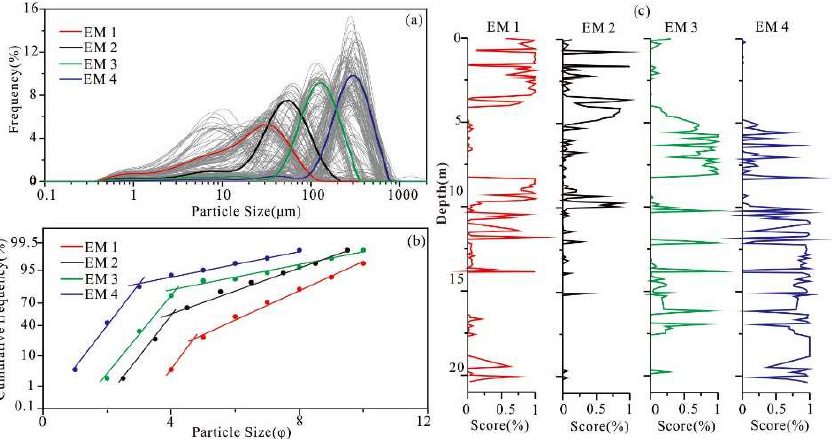
Figure 4. The hierarchical clustering endmember modeling analysis results. ( a ) Grain-size distributions (GSDs) of samples from sediment core HDZ04 and the GSDs of four endmember (colored lines) by the CEMMA. ( b ) Probabiity cumulative curves for four endmember. ( c ) End-member score (%).